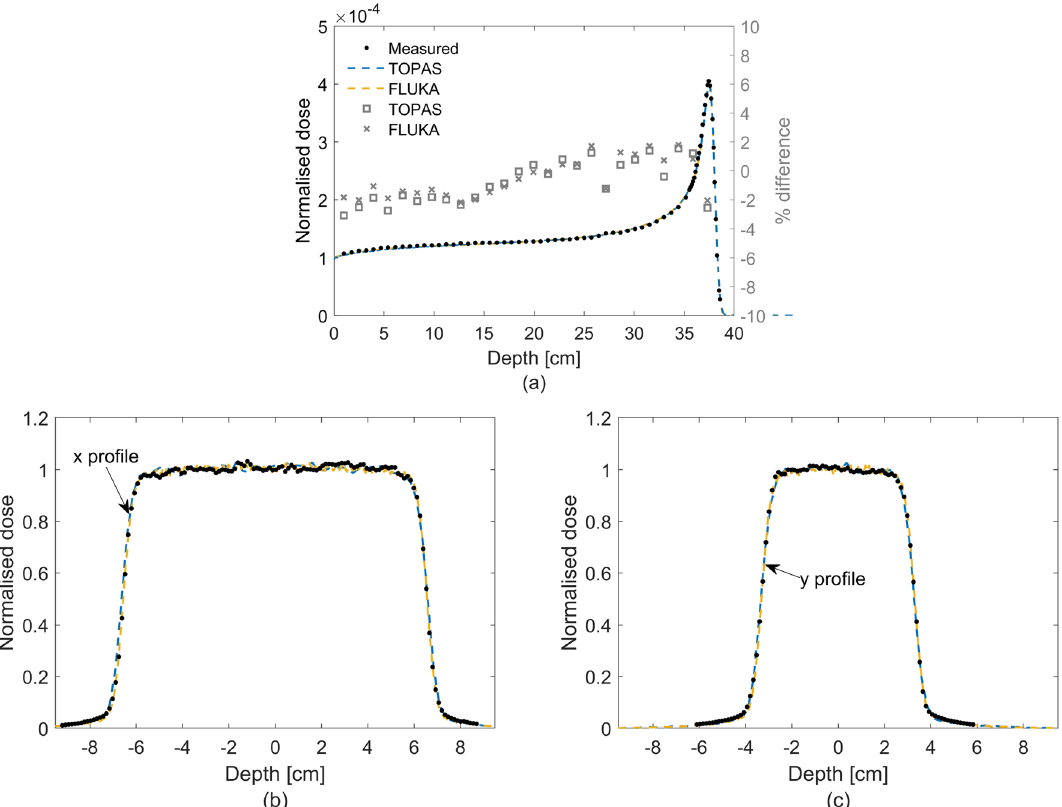
Figure 2. Measured and simulated dose distributions for the field 12 × 5 cm 2 . Depth- ( a ) and lateral-dose distributions ( b , c ). Solid circles represent the measured data, dashed curves represent the simulated data, and open squares and crosses the percentage difference between simulated and measured data using TOPAS and FLUKA, respectively. The field sizes were defined at the 90% of the isodose line. For simplification, the fields were named to the field size rounded down to the nearest